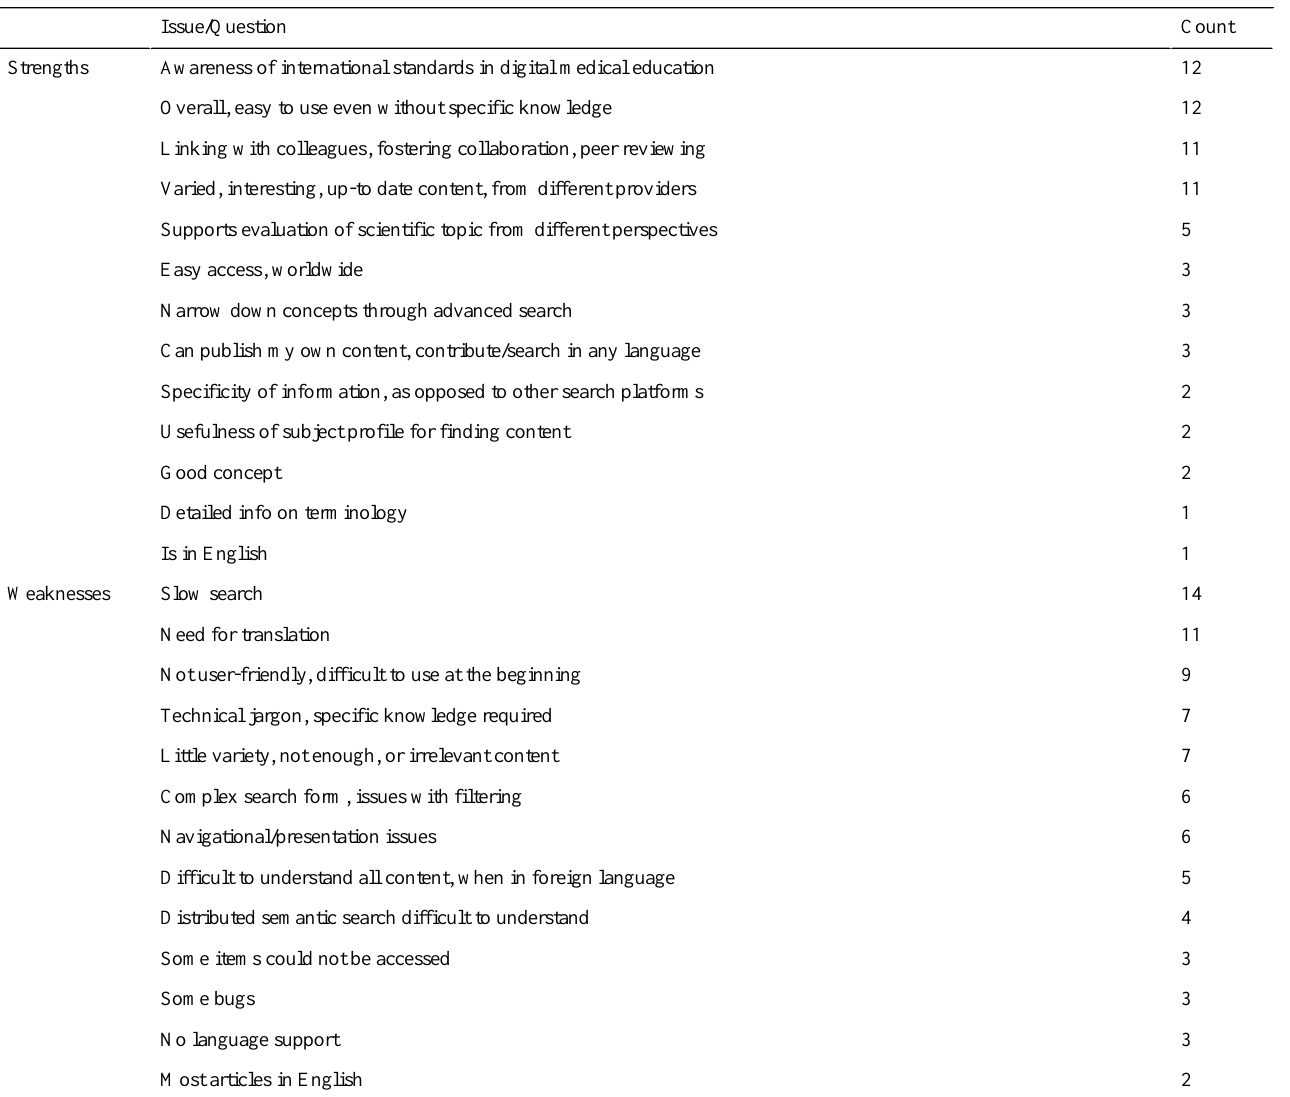
Table 3. Content analysis of open responses to the online survey indicating strengths and weaknesses of the mEducator